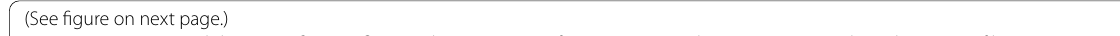
SEM. ± . The local details are enlarged in ×